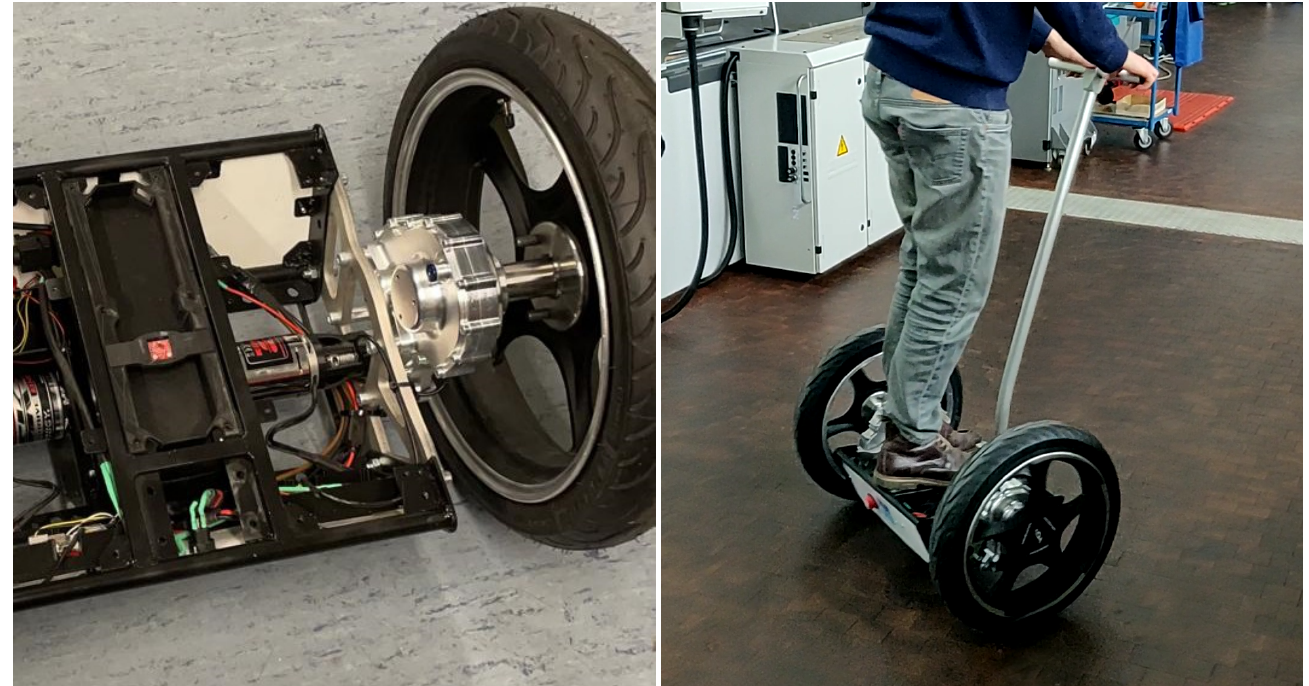
Figure 26. Build balanced two-wheel